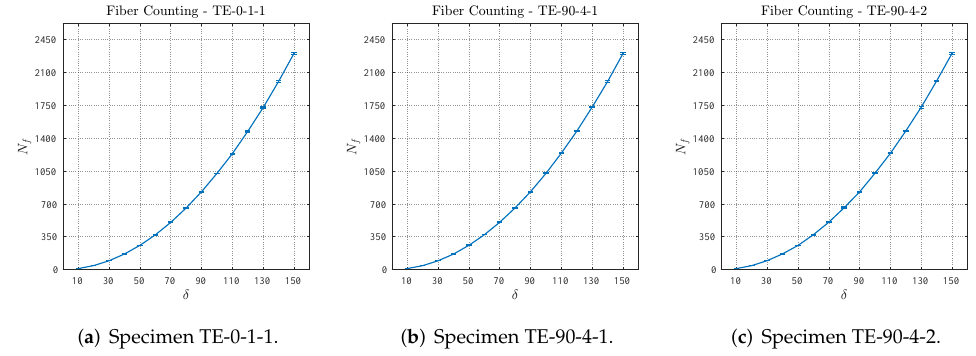
Figure 9. Number of fibers computed for different sizes of cropped regions.